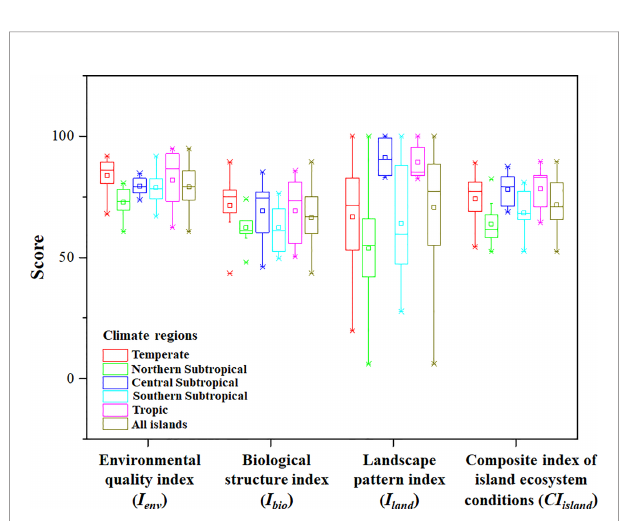
FIGURE 4 | Integrated assessment results of island